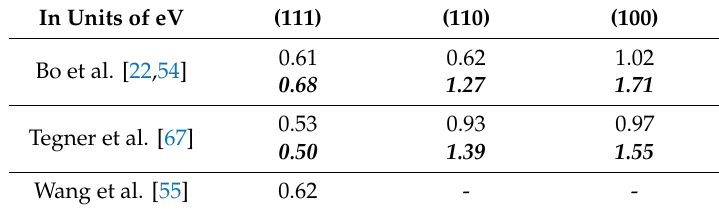
Figure 8. H 2 O on ThO 2 (111) surface [38]. Top and side views of molecular adsorption ( a , b ) and dissociative adsorption ( c , d ). Table 5. Adsorption energies of one H 2 O molecule on perfect UO 2 surfaces. The bold italic numbers correspond to adsorption energies in the dissociative form. The rest are adsorption energies in the molecular